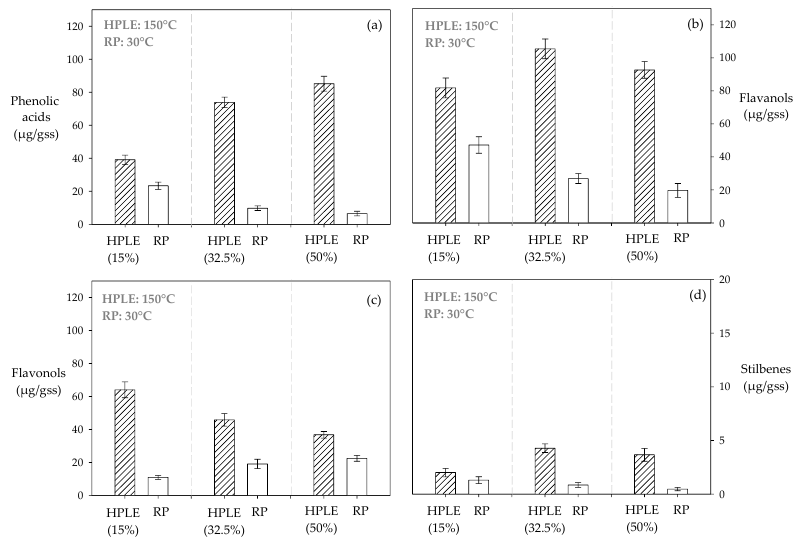
Figure 2. Effect of co-solvent addition on the recovery of polyphenol families in an integrated HPLE-resin purification (RP) process: ( a ) phenolic acids; ( b ) flavanols; ( c ) flavonols; ( d ) stilbenes (resveratrol).